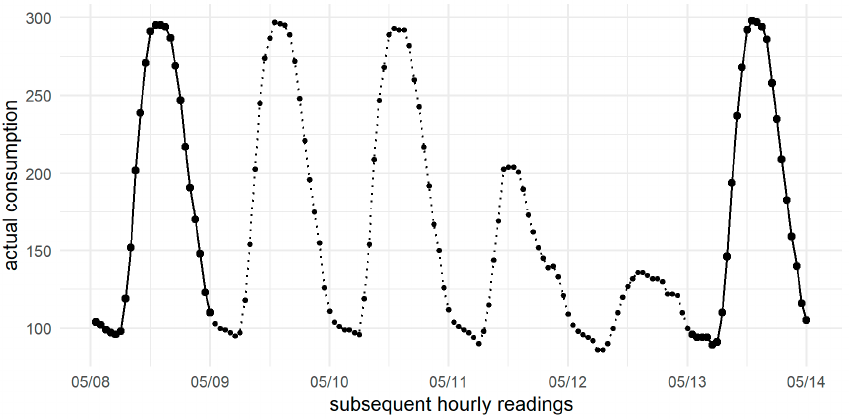
Figure 11. Actual consumption of PPE-Example4 with missing values inserted. Source: own elaboration. shown in Figure 12. The gray line is actual consumption, the red line is imputation using method 1 (exactly), the yellow line is imputation method no. 2, the blue line is imputation method no. 3.